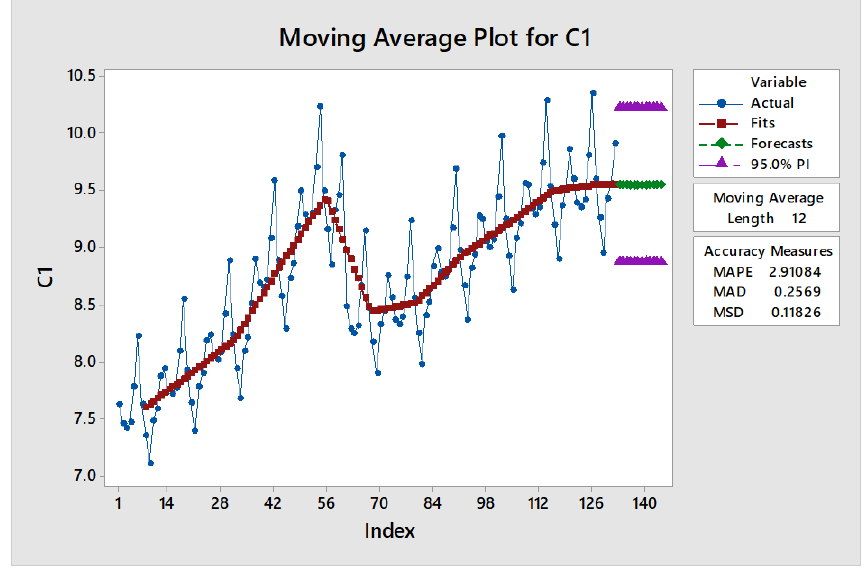
Fig 7. Forecast result using moving average output from Minitab 18